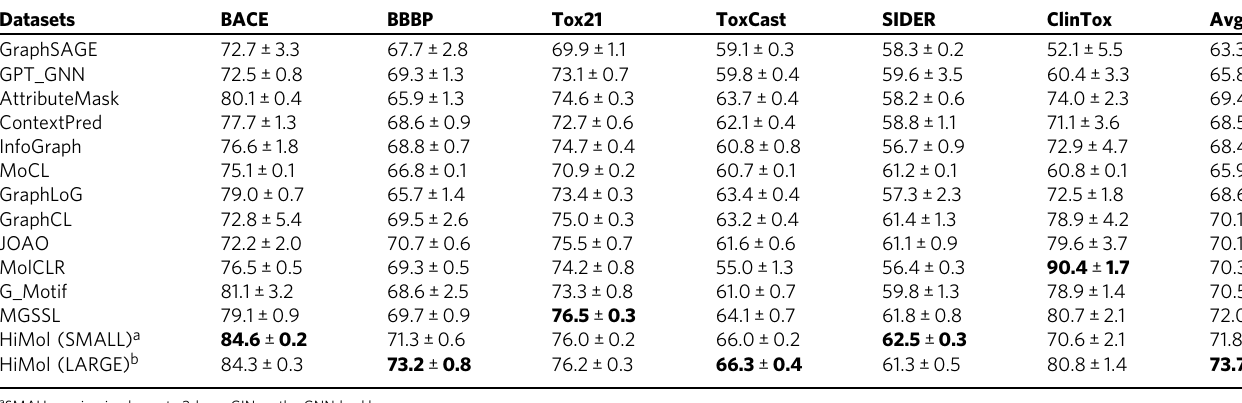
Table 1 Molecular property prediction performance on classi fi cation